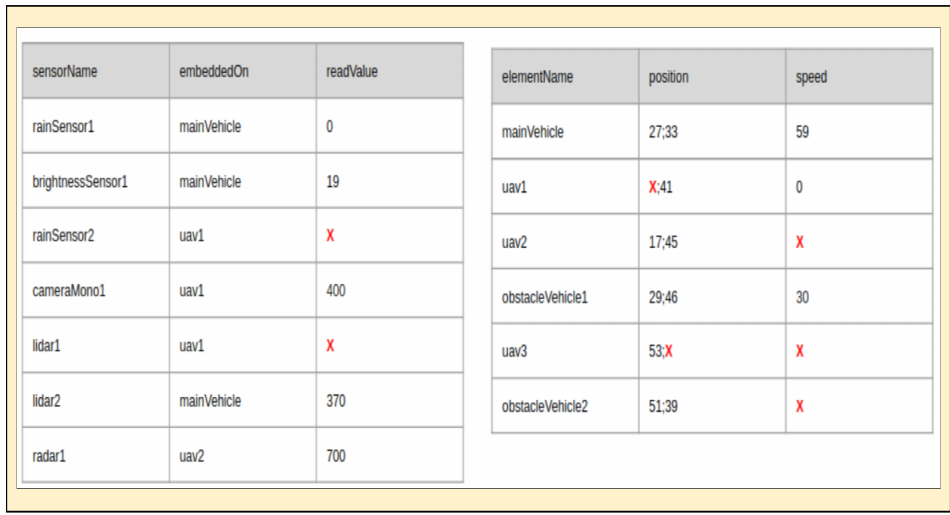
Figure 27. Data obtained with some missing values (represented as x in